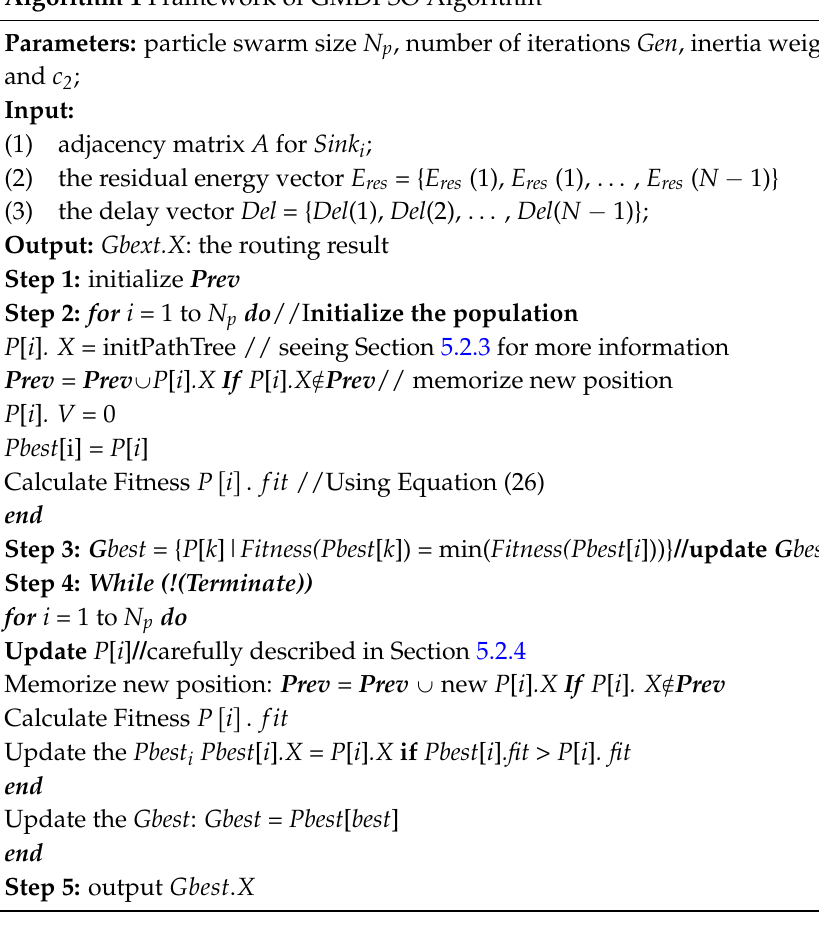
Algorithm 1 Framework of GMDPSO